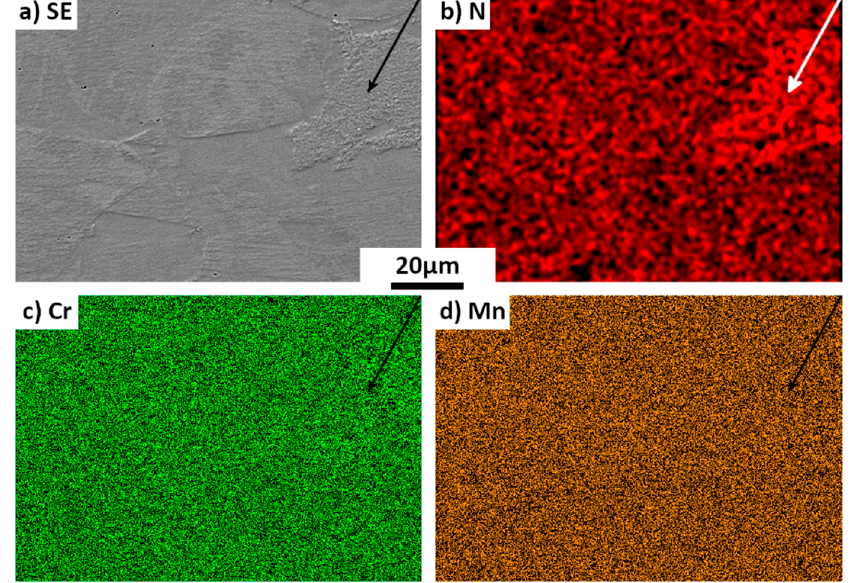
Figure 7. Micrograph and chemical maps of an area of as received sample (25%-drawn), annealed at 575 °C for 978 h. ( a ) secondary electron (SE) micrograph, ( b – d ) maps of the chemical element distribution of the same area. The arrows indicate the newly formed structure.